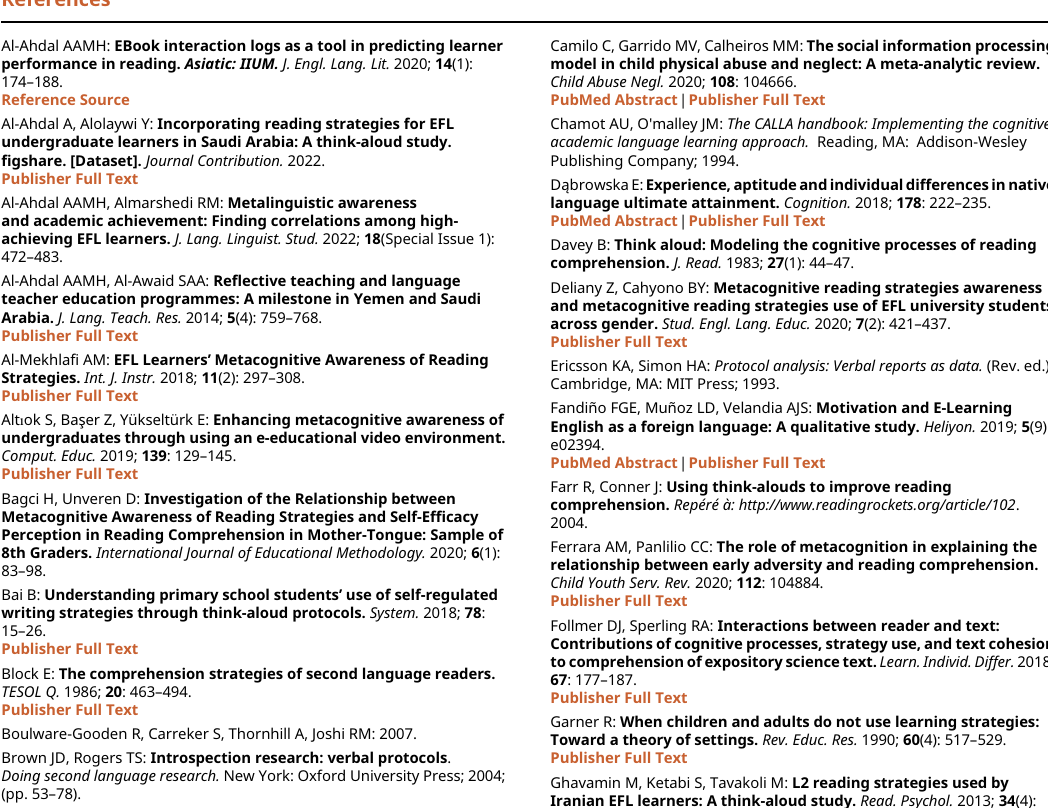
Figshare: Incorporating reading strategies for EFL undergraduate learners in Saudi Arabia: A think-aloud study.